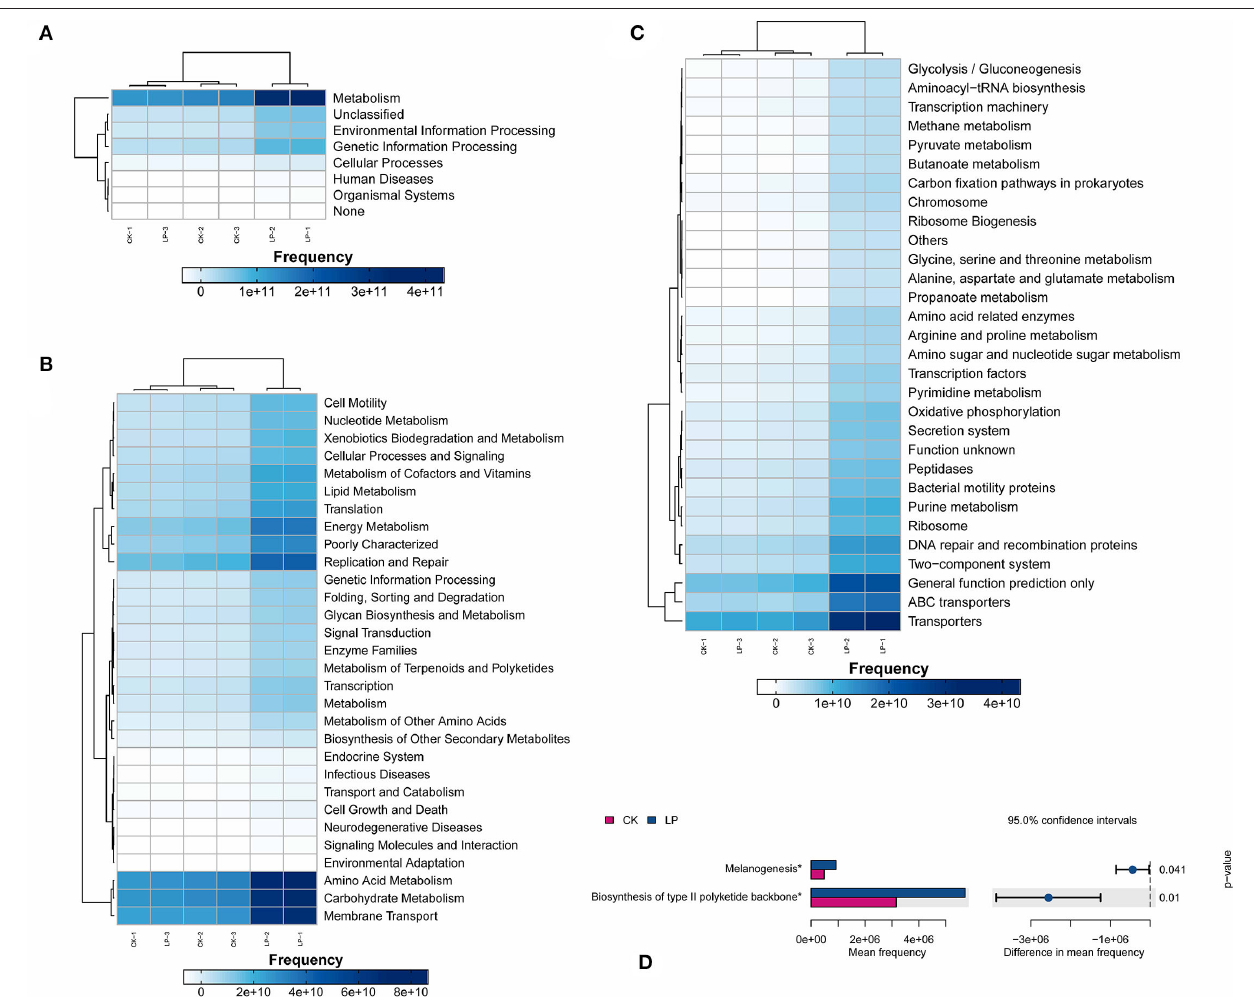
FIGURE 7 | Functional predictions of the soil microbiota. (A–C) represent functional genes annotated in the KEGG database at levels 1–3, respectively; (D) The significantly different pathway genes between groups, *Significant correlation at p ≤ 0.05; CK, monoculture of litchi; LP, intercropping of litchi and Pinto